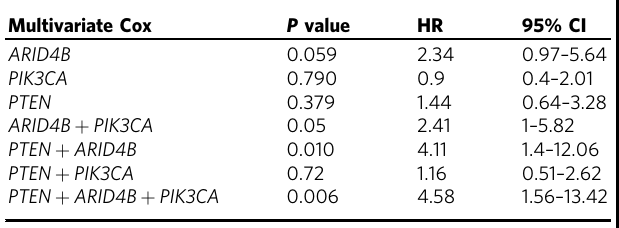
Table 2 PTEN plus ARID4B and PIK3CA increased predictive power for prostate cancer recurrence in multivariate Cox regression analysis using the human prostate cancer